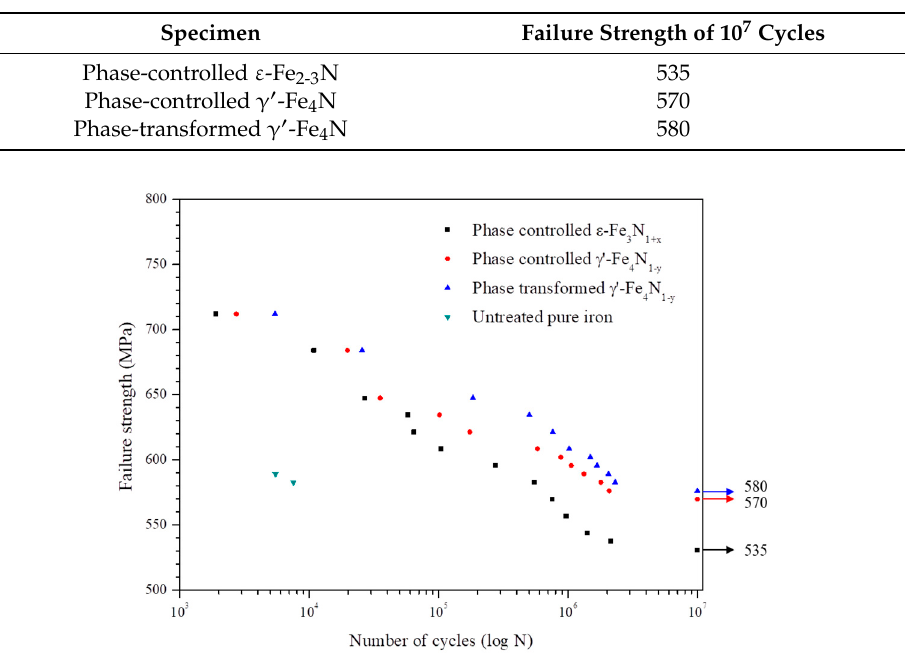
Figure 9. S-N curve diagram of pure iron after gas nitriding with various nitriding conditions.